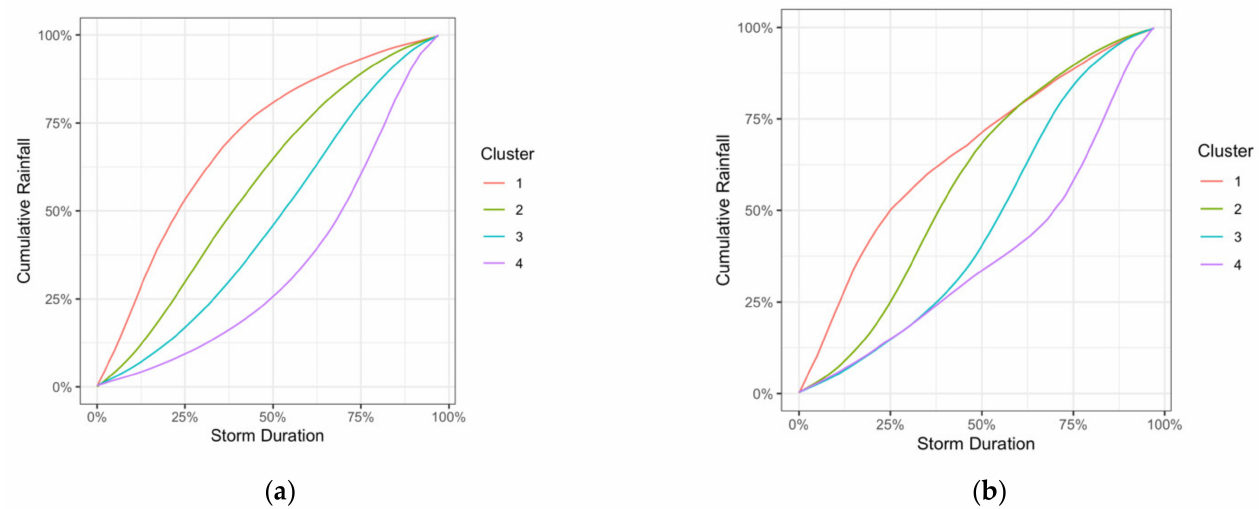
Figure 9. ( a ) Unitless cumulative values using FCM. ( b ) Unitless cumulative curves using Huff’s